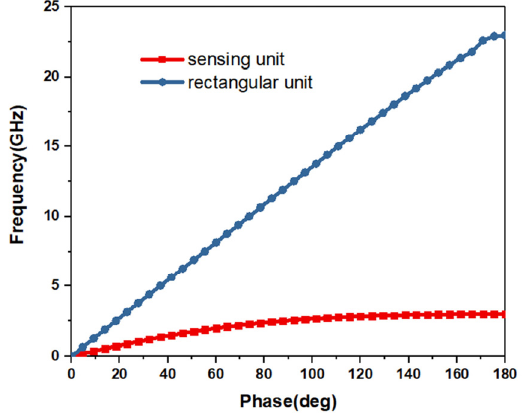
Figure 5. Dispersion plots of sensing unit and rectangular unit.